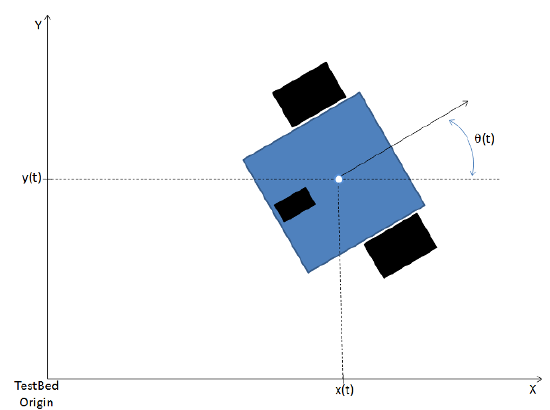
Figure 1. Illustration of Robot Orientation Reference